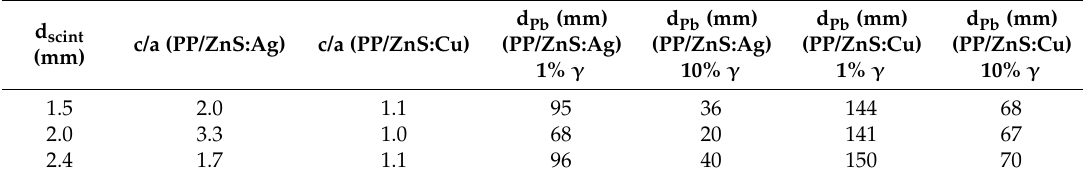
Table 2. Ratios of the amount of detected neutrons to detected gamma rays (c/a) without lead filter and thicknesses of lead filters (d Pb ) required to limit the gamma contribution in the detected beam to less than 1% and 10%, respectively. d scint c/a (mm)